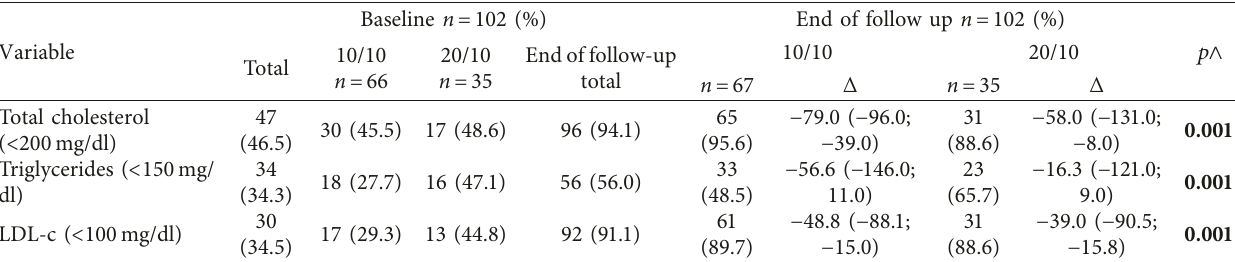
Figure 3: Percentage of patients that achieved therapeutic goals for total cholesterol, triglycerides, and LDL-c at the end of the follow up, compared to baseline. A p value of < 0.05 was taken as statistically significant. Table 5: Proportion and deltas of patients who achieved therapeutic goals for total cholesterol, triglycerides, and LDL-c per dose at the end of follow up compared to